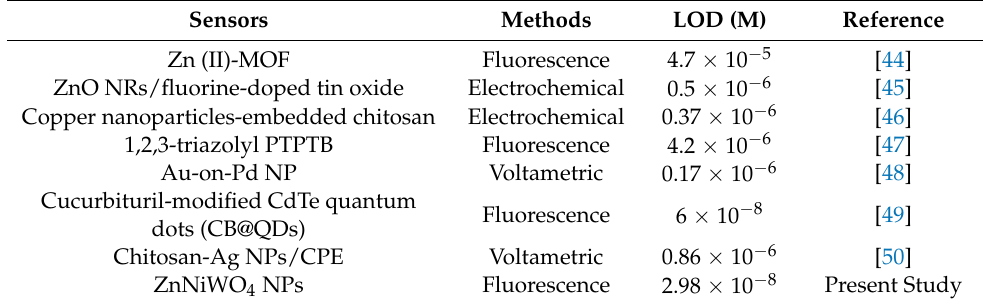
Table 3. Comparison of LOD with the literature.